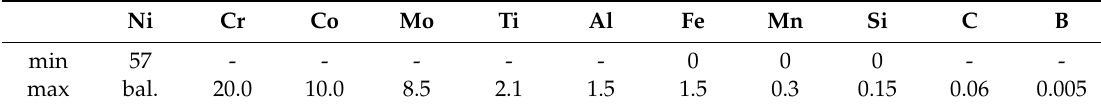
Table 2. Chemical composition of HS 282 in weight percent [14].